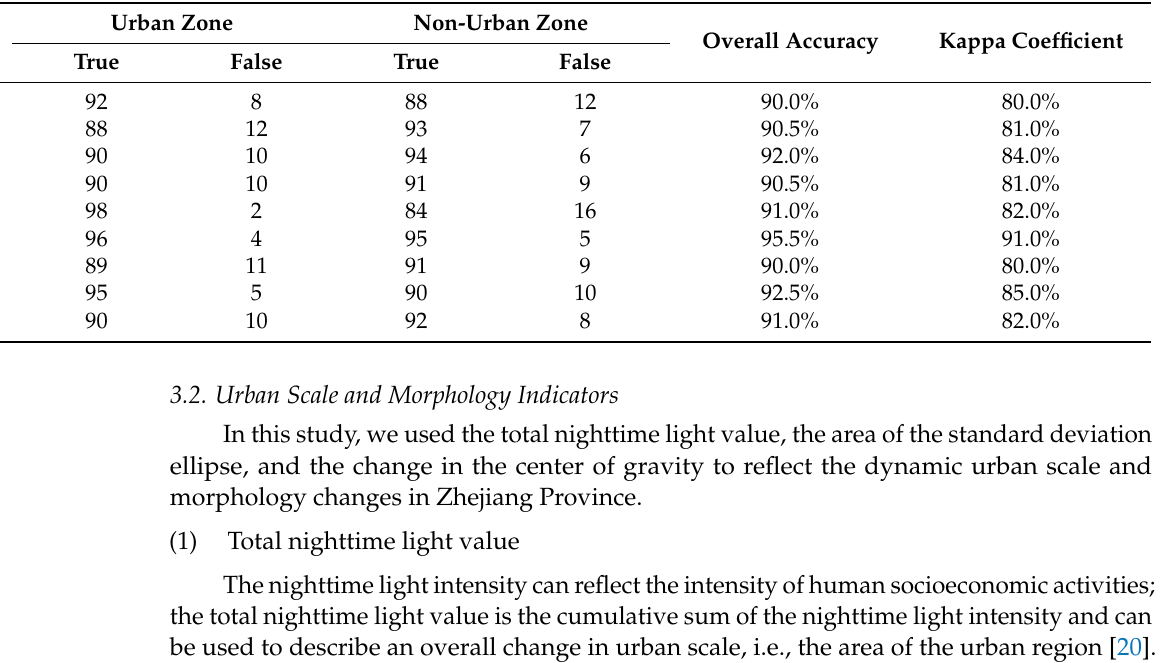
Table 1. Accuracy test results of the extracted urban areas in Zhejiang